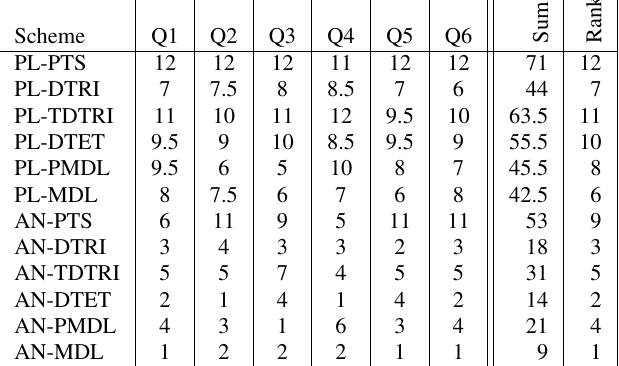
Question-wise rankings for all the visualization schemes. Lower values of ranks are